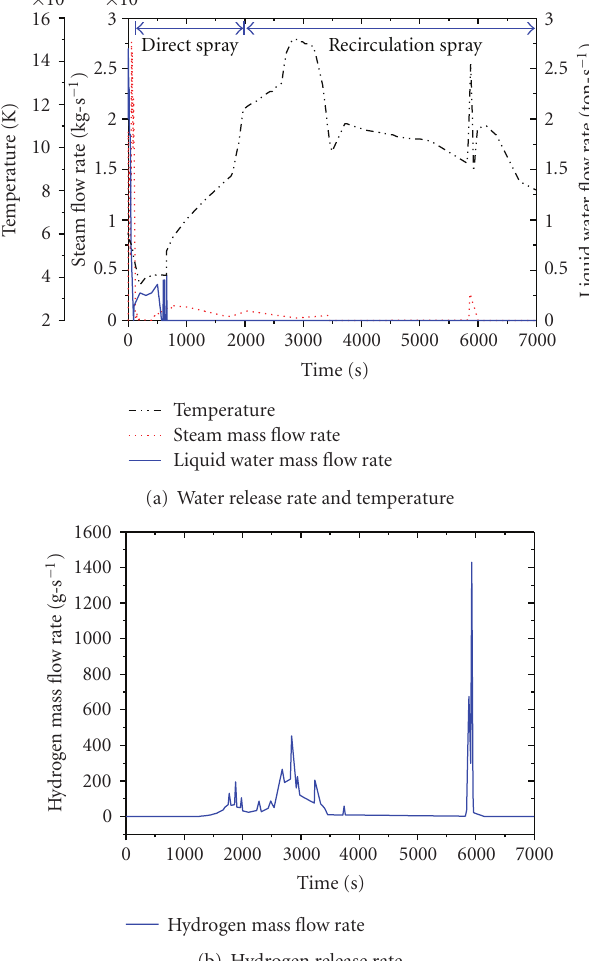
Figure 3: Source term and spray